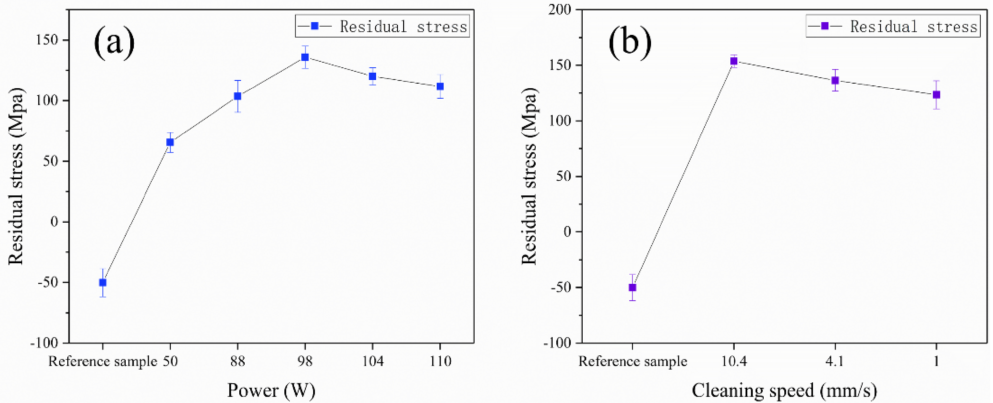
Figure 12. ( a ) Surface residual stress of aluminum alloy after laser cleaning under di ff erent powers; ( b ) surface residual stress of aluminum alloy after laser cleaning at di ff erent